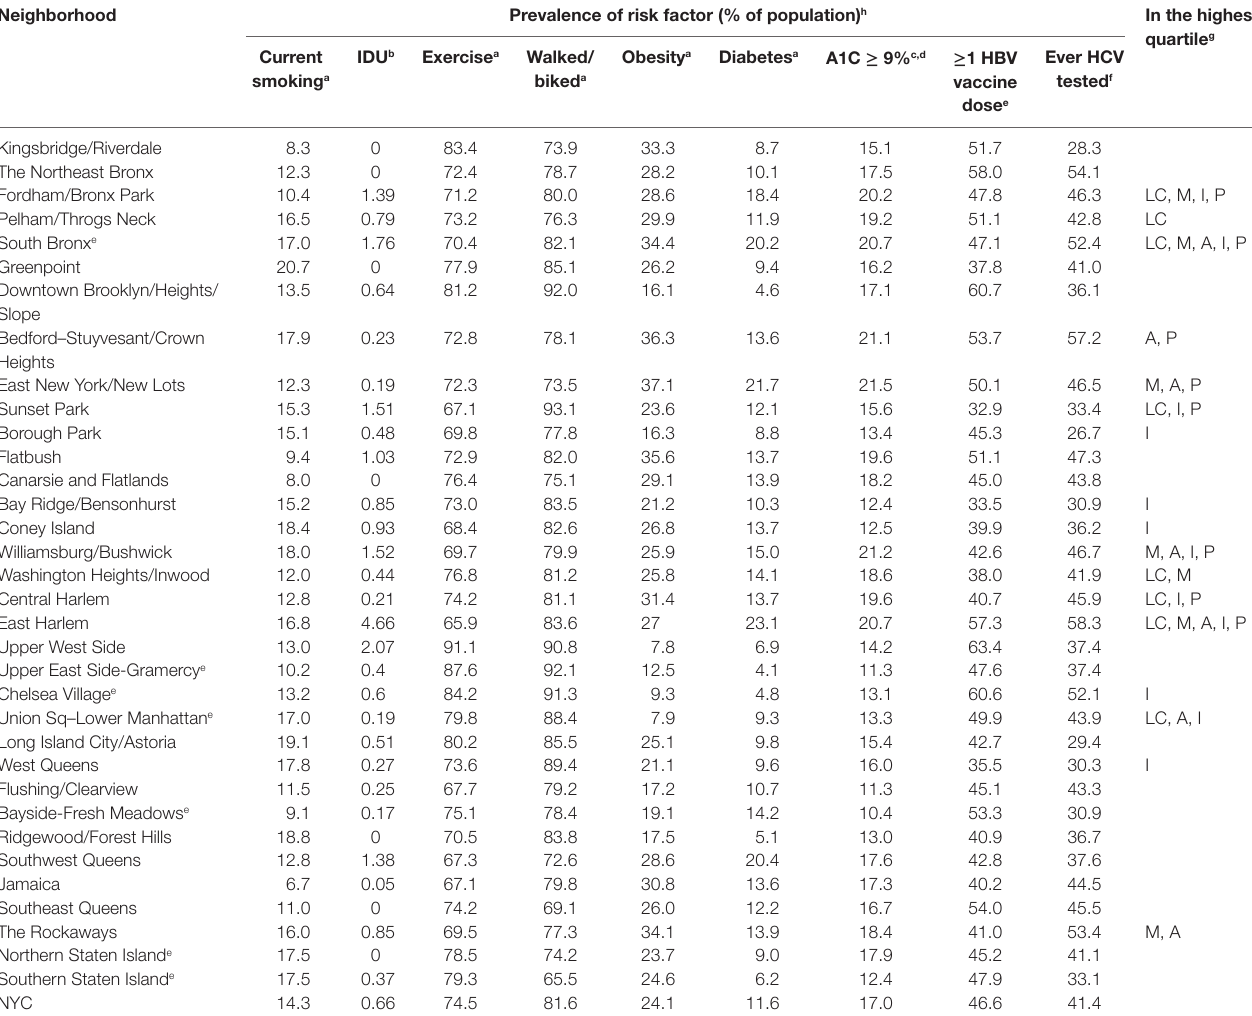
TaBle 2 | Distribution of behavioral liver cancer risk factors according to neighborhood.